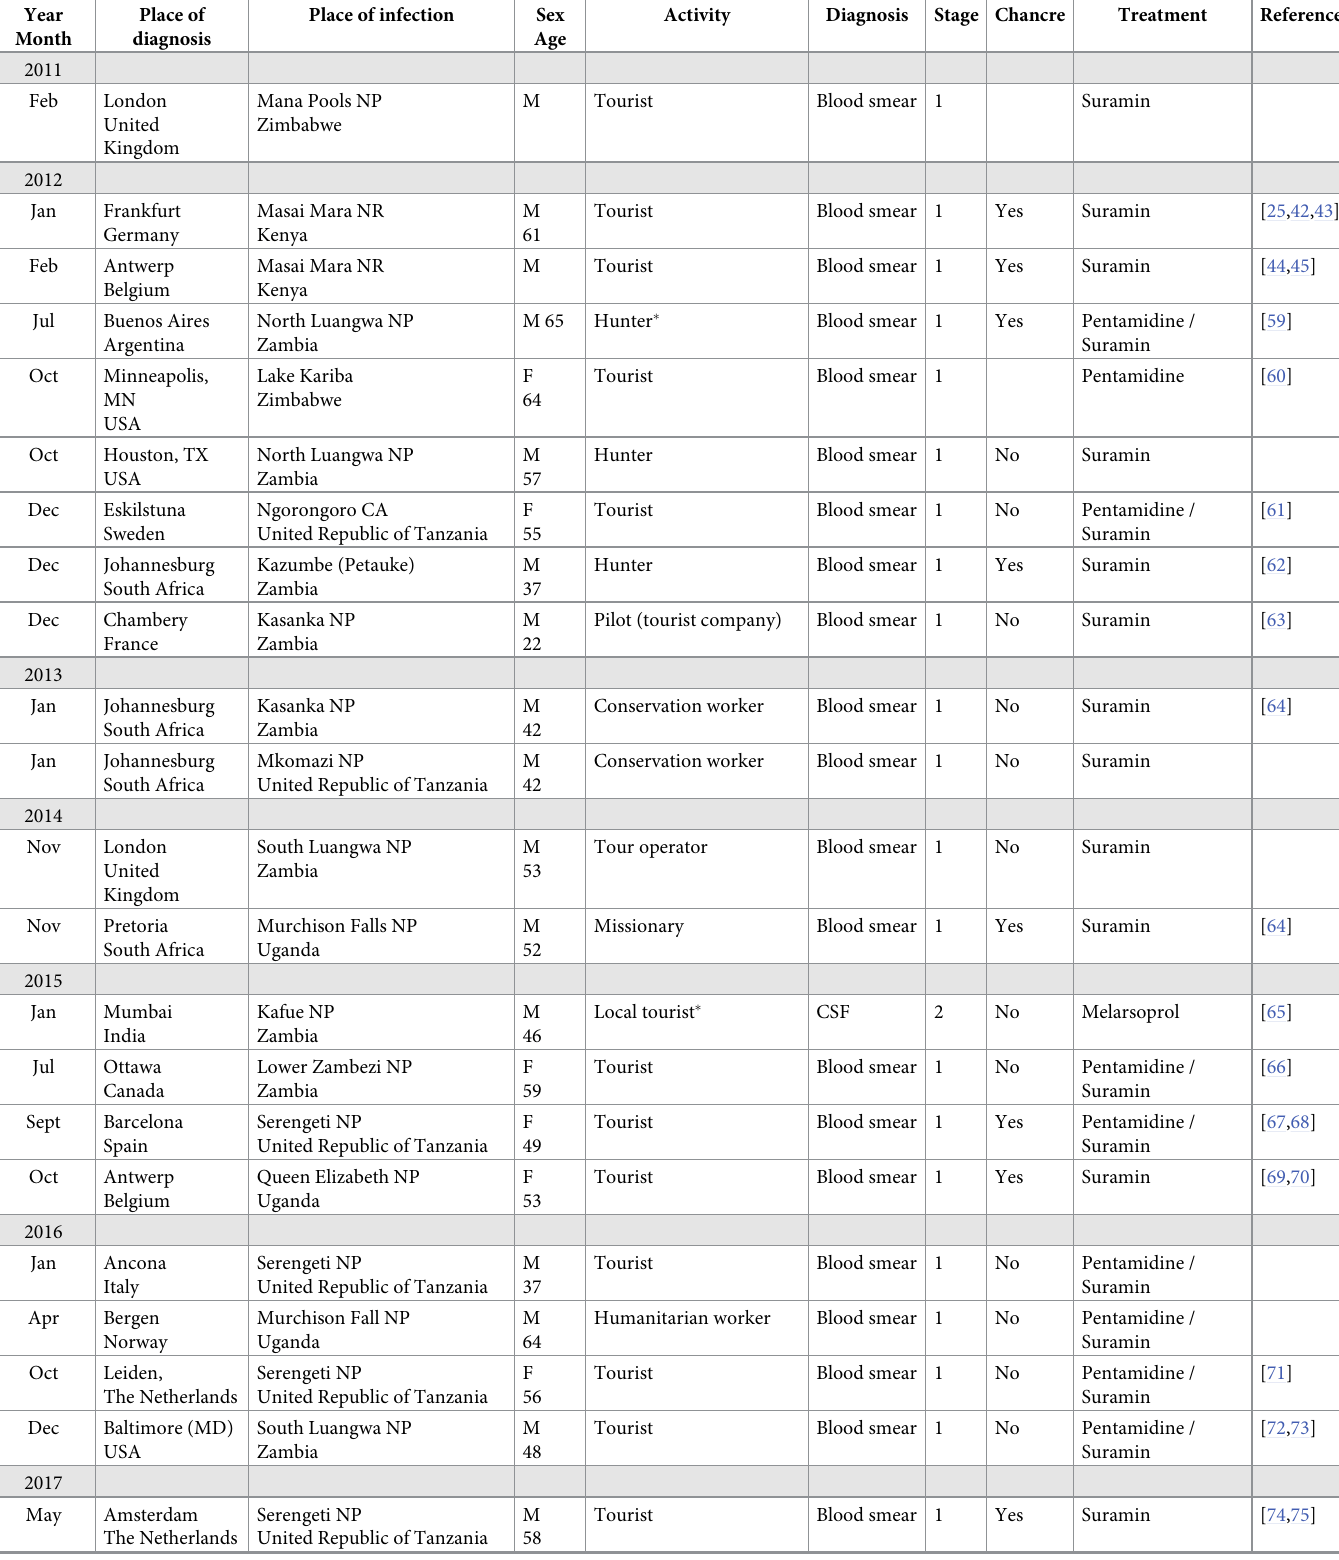
Table 2. Cases of rhodesiense HAT diagnosed in non-DEC.